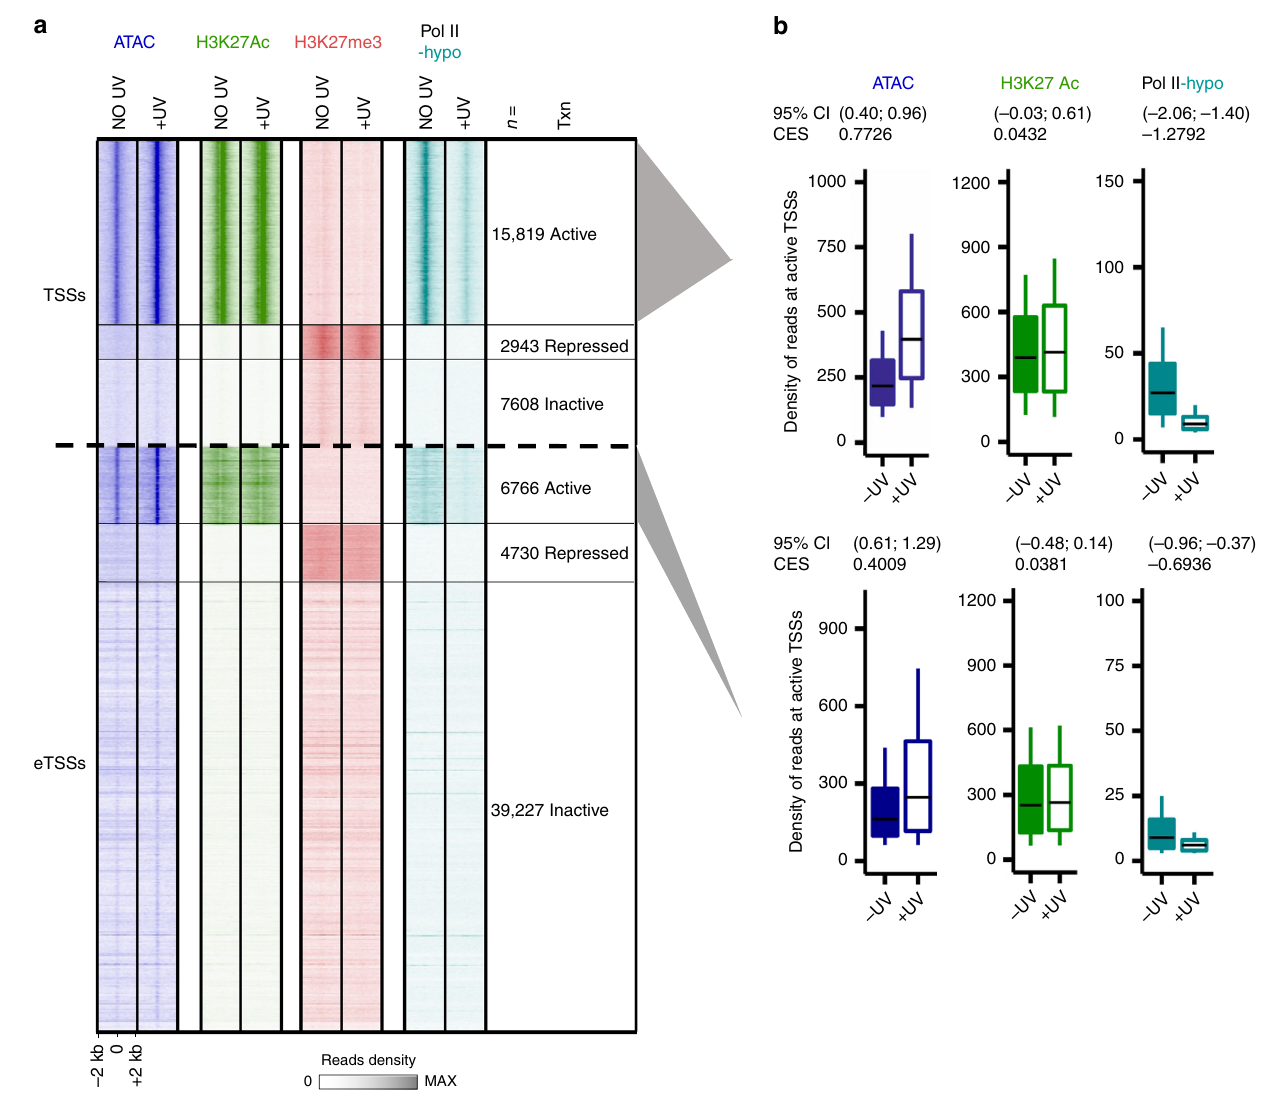
Fig. 2 Histone modi fi cations remain virtually stable upon UV damage. a Heatmap depicting read densities for ATAC-seq, H3K27ac, H3K27me3, and Pol II-hypo ChIP-seq before (NO UV) and at 2 h post UV ( + UV: ATAC and H3K27ac: 15 J/m 2 , H3K27me3: 20 J/m 2 ), for genomic regions 2 kb around active, inactive, and repressed TSSs and eTSSs, respectively. Data for Pol II-hypo are obtained from ref. 25 (at 1.5 h post UV with 8 J/m 2 , see “ Methods ” for details). b Boxplots summarizing quanti fi cations of ChIP-seq reads shown for active TSSs and eTSSs, respectively. Boxplots show the 25th – 75th percentiles, and error bars depict data range to the larger/smaller value no more than 1.5 * IQR (interquartile range, or distance between the fi rst and third quartiles). In all, 95% con fi dence intervals (CI) of mean differences between + UV and NO UV of log 2 counts were calculated for 10,000 samplings of 100 data points with replacement from each population. Effect sizes of log 2 counts between irradiated and nonirradiated samples were calculated by using Cohen ’ s method